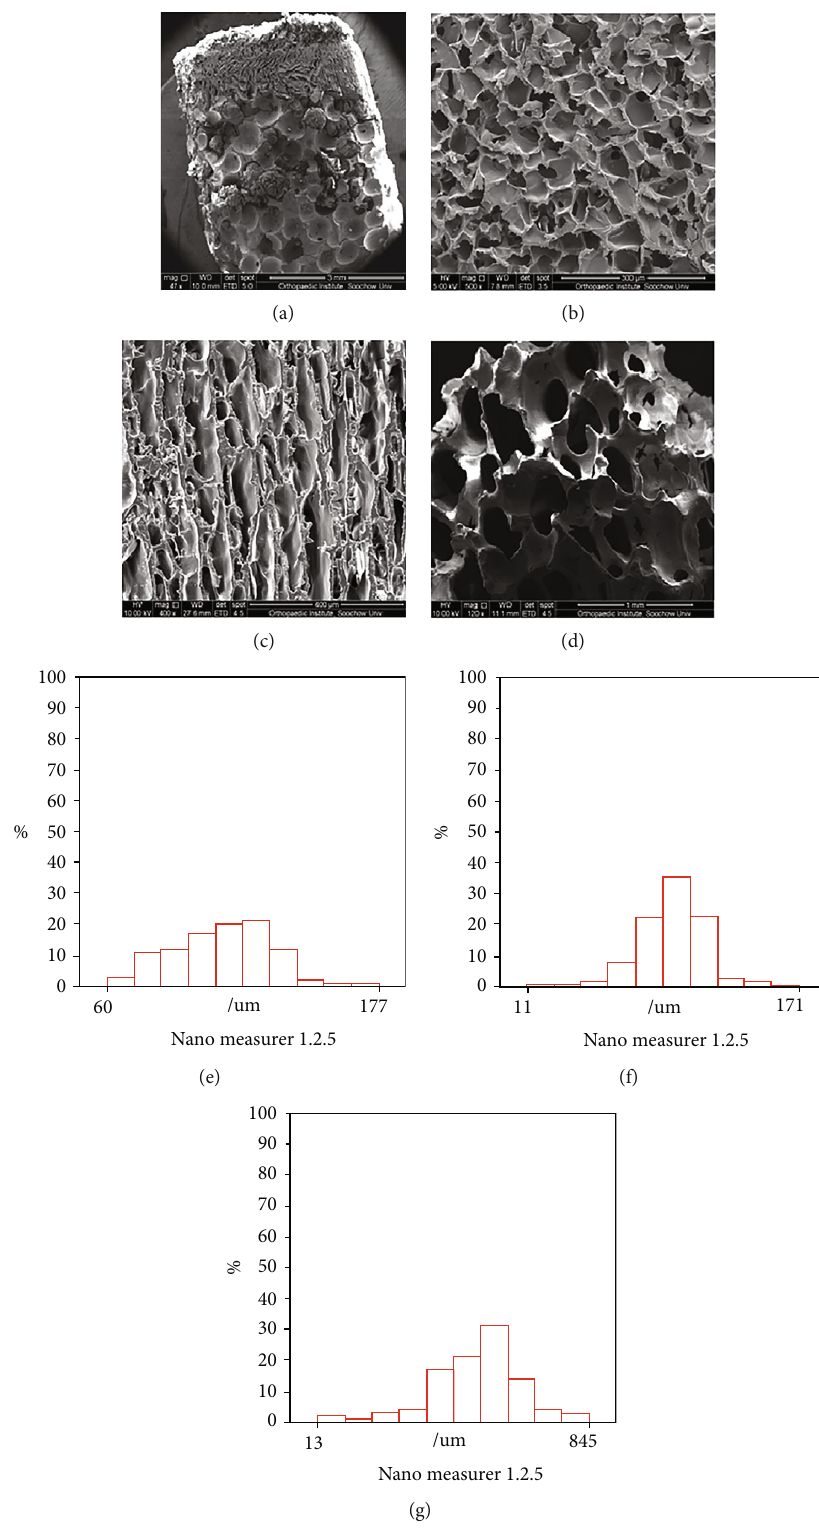
Figure 2: SEM image of porous structure of the sca ff old ((a) scale bar = 3 mm ) and the gradual porous structure of cartilage phase ((b) scalebar = 300 μ m ), interface layer ((c) scalebar = 400 μ m ), and bone phase ((d) scale bar = 1 mm ). Pore size distribution of cartilage phase (e), interface layer (f), and bone phase (g) under